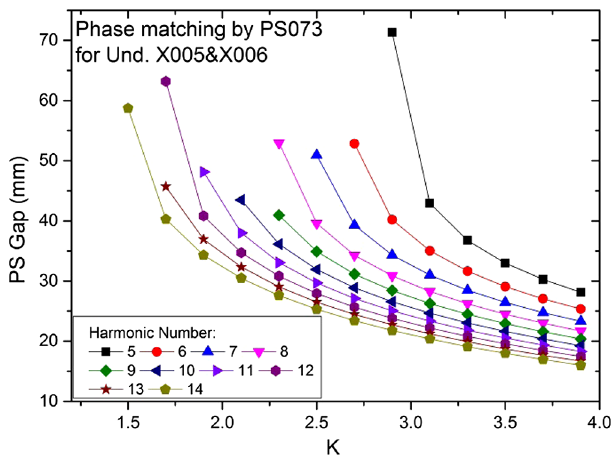
FIG. 8. The required gap of phase shifter PS073 placed between U40-X005 and U40-X006 as a function of the K-parameter. The individual curves correspond to different phase